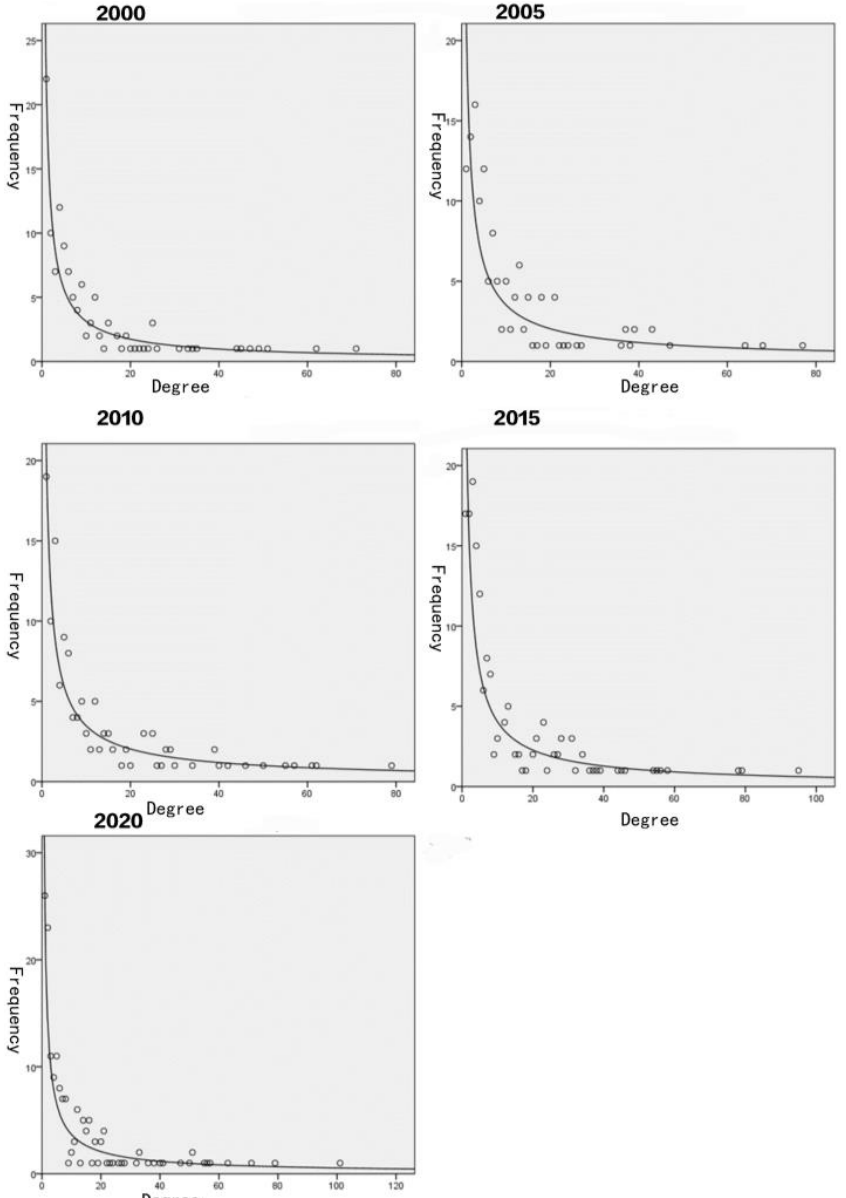
Figure 1. Power law distribution fitting of node degree of GSTN in 2000, 2005, 2010, 2015, and 2020 (data source: FAO). Note: degree (X-axis) is the number of direct trading partners of a country; frequency (Y-axis) is the number of countries with a certain degree.